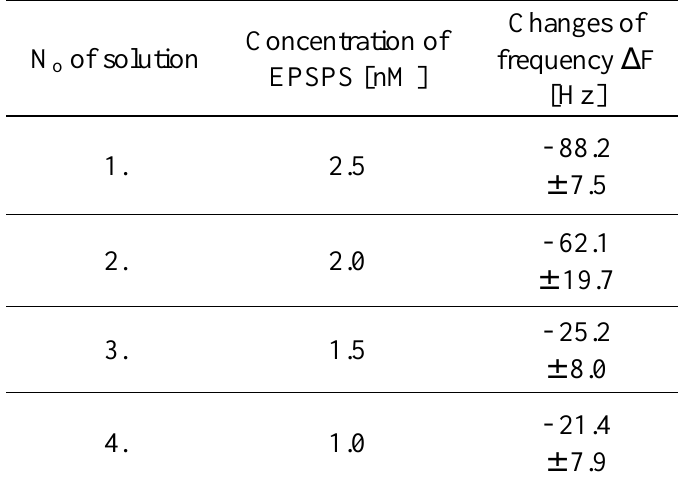
Table 2. The selectivity of the piezoelectrode modified with probe 1 after hybridization process with complementary PCR product (fragment of EPSPS gene) in absence (A) and presence of noncomplementary PCR product (fragment of Adh gene)